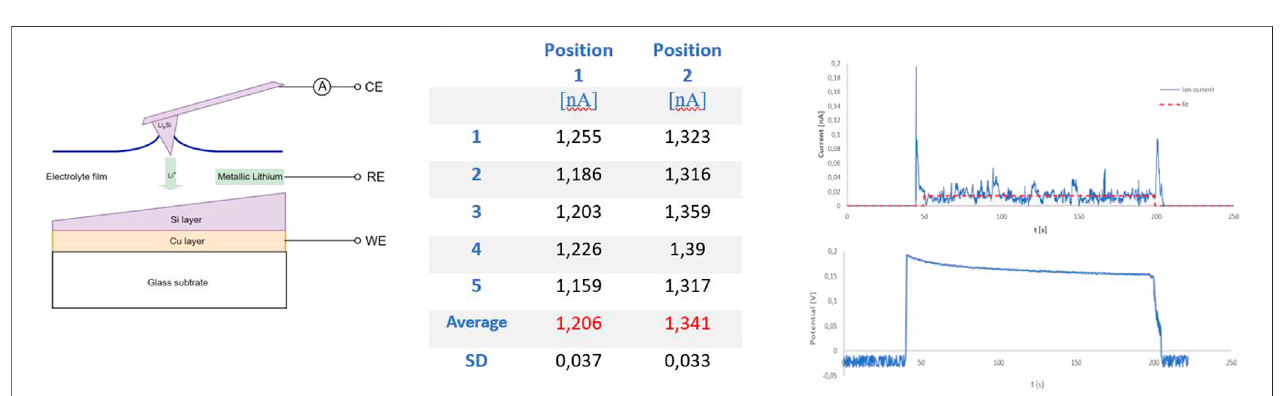
FIGURE 10 | Left: the lithiated probe as an active component in the battery process. Middle and right: Ion current measurements.